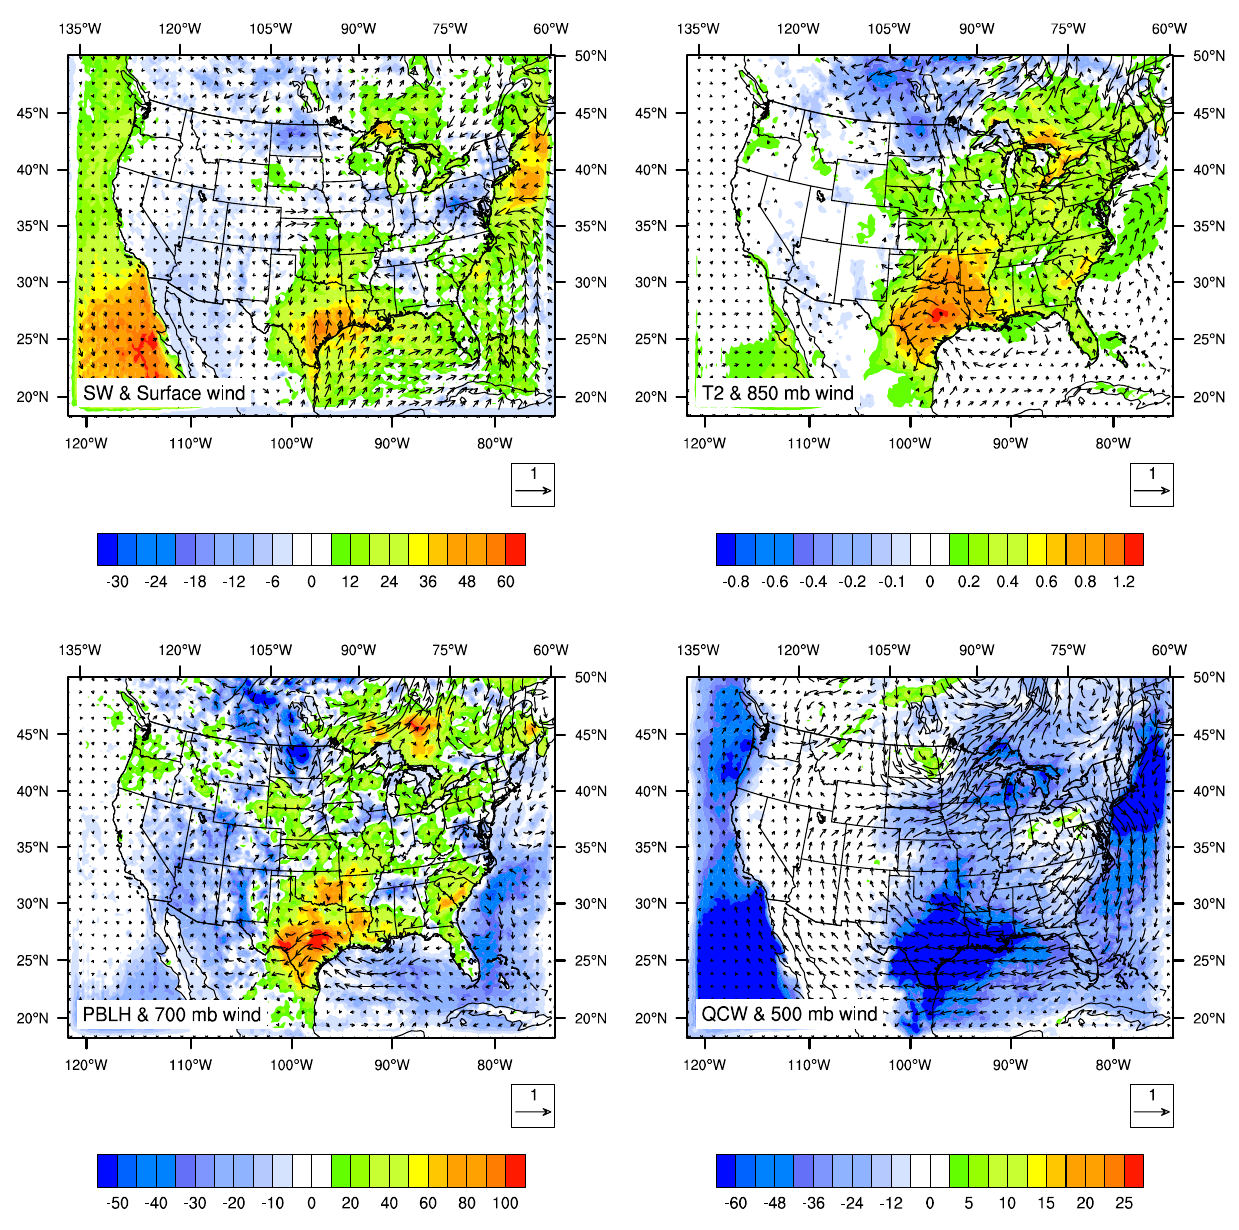
Figure 4. Spatial distribution of changes in the three-month average downward shortwave radiation (SW, W·m − 2 ), T2 (K), planetary boundary layer height (PBLH, m), and cloud liquid water path (QCW, g·m − 2 ) due to ACR. The changes in wind (m·s − 1 ) overlaying the above meteorological parameters are at surface 850 mb, 700 mb, and 500 mb,